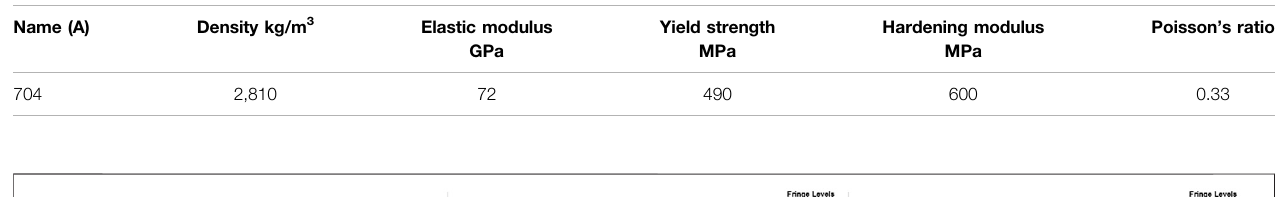
TABLE 2 | Main mechanical properties of shell and tail cover material.